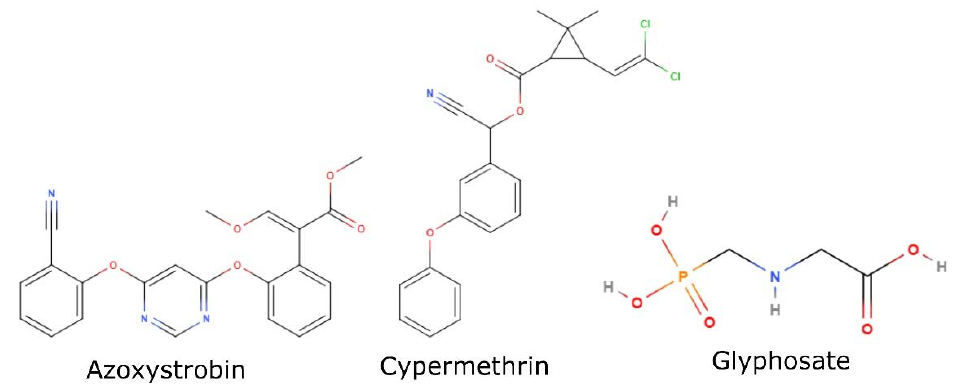
Figure 1. Chemical structures of azoxystrobin, cypermethrin, and glyphosate.